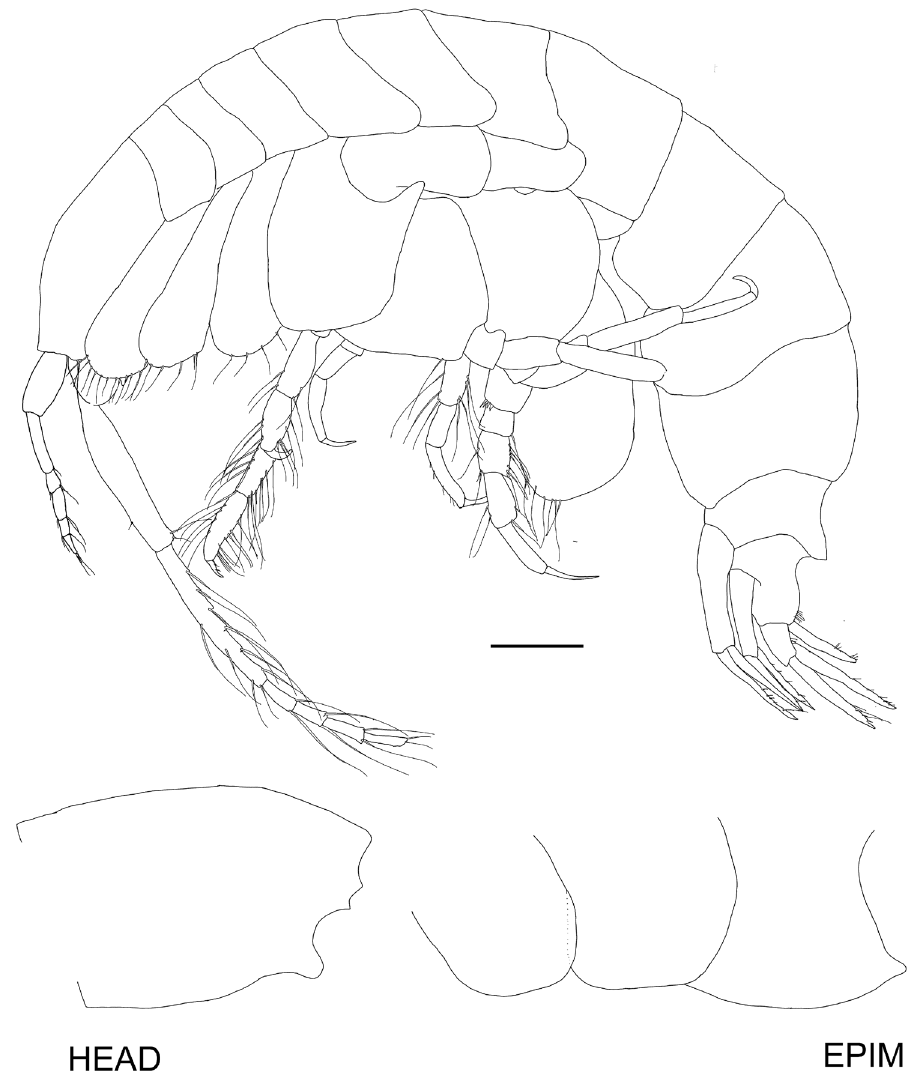
Figure 2. Byblisoides bellansantiniae sp. n. Holotype, female, 14 mm, ZMH K-47035, Irminger Basin, Iceland, 2537.3–2538.1 m. Whole animal, head and epimeron. Scale for habitus represents 1 mm.